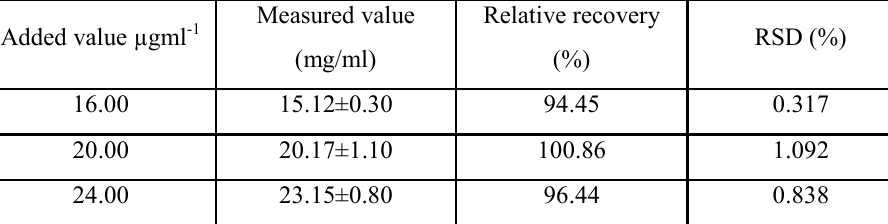
Table 1. Accuracy data for the developed method (n =